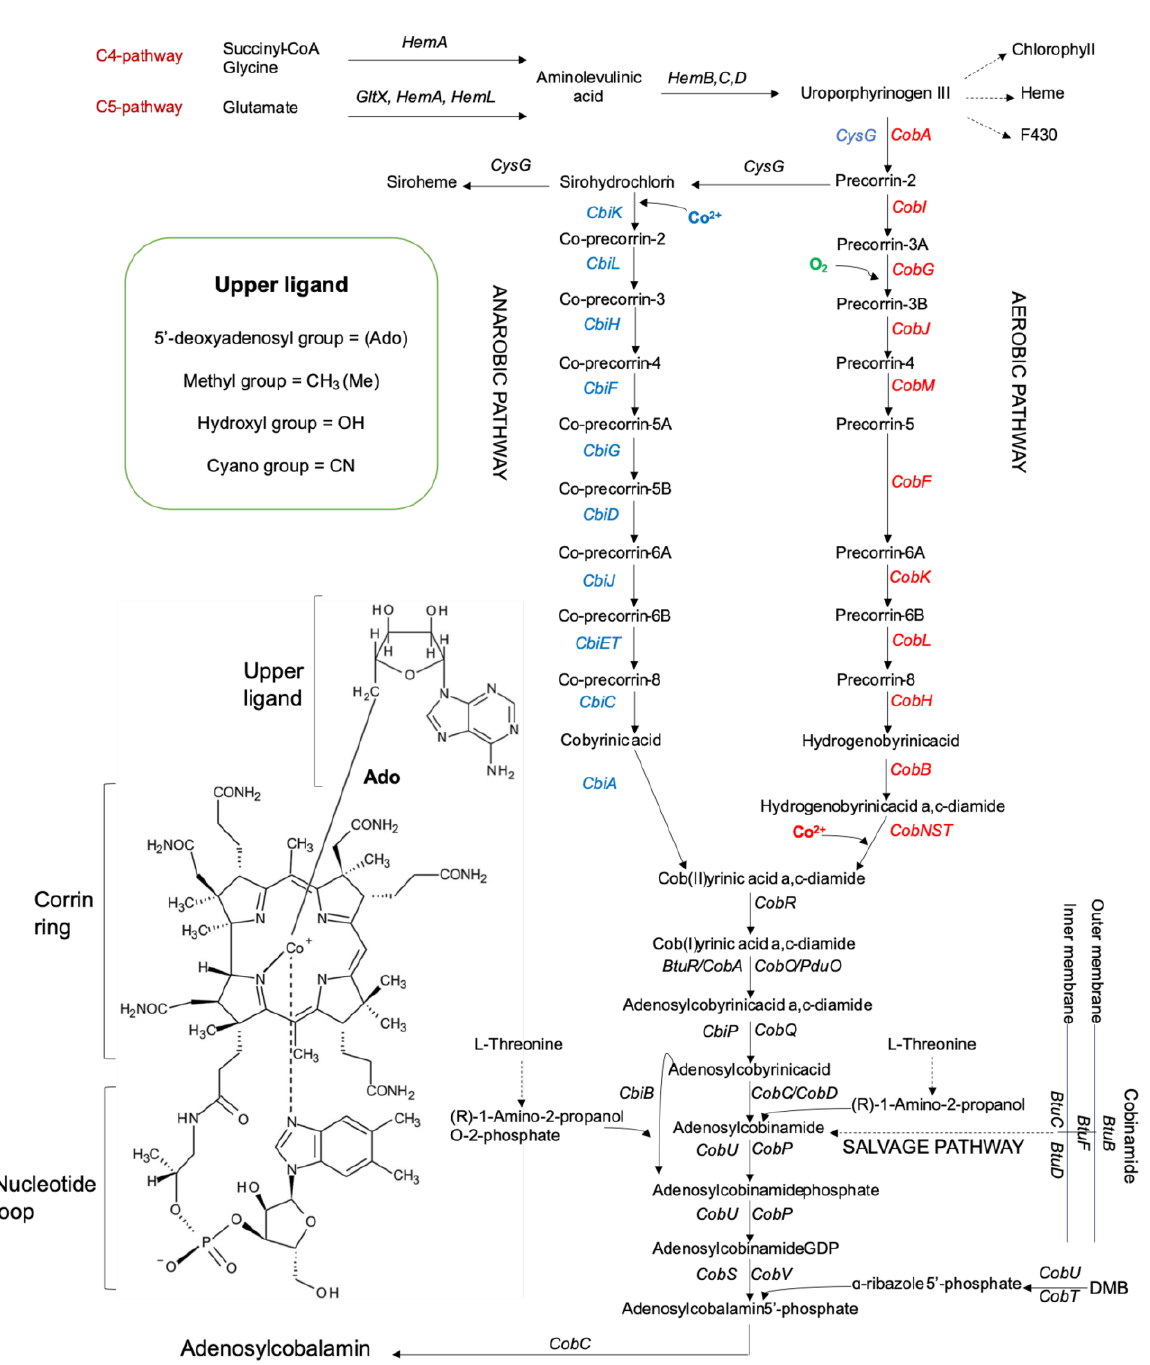
Figure 1. Scheme of the aerobic, anaerobic and salvage cobalamin biosynthetic pathways: the aerobic pathway is shown for P. denitrificans or Sinorhizobium meliloti (the intermediates are outlined on the right), and the anaerobic pathway and its intermediates are outlined on the left for well-studied bacteria S. typhimurium , P. shermanii and B. megaterium ; the structure of vitamin B12 with the lower ligand 5,6-dimethylbenzimidazole (DMB) and the upper ligand consisting of either 5′-deoxyadenosyl, methyl, hydroxyl or cyan group, with their respective names being adenosylcobalamin (AdoCbl), methylcobalamin (MeCbl), hydroxocobalamin (OHCbl) and cyanocobalamin (CNCbl); the gene names are in blue, red, and black and used throughout this work. The anaerobic and aerobic cobalamin pathways are characterized by the early and late cobalt insertions, respectively. In the anaerobic pathway, CysG is a common enzyme for siroheme and cobalamin synthesis. Whilst decarboxylation of UroIII leads to the biosynthesis of hemes and chlorophylls, methylation of UroIII at C-2 and C-7 results in the synthesis of precorrin-2, that is also the last common intermediate in the synthesis of coenzyme F430 and siroheme [7,9,20,24].